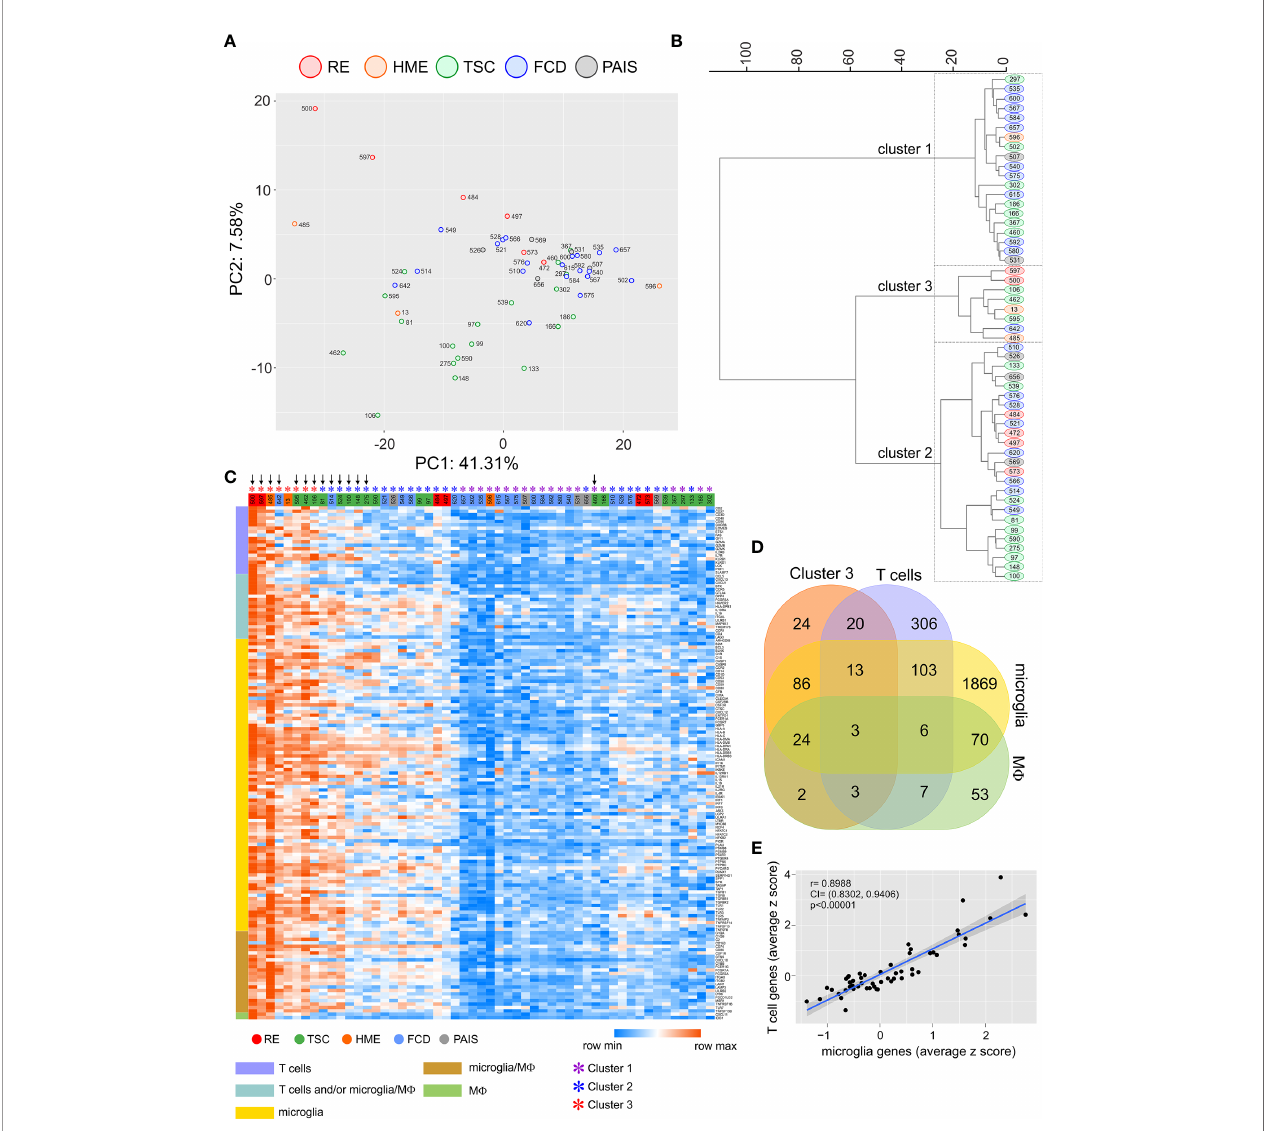
FIGURE 1 | Quanti fi cation of immune cells transcripts in resected brain tissue from epilepsy surgeries. A NanoString ® immune cell pro fi ling oligonucleotide array was used to quantify transcripts expressed by T cells, macrophages and microglia in brain specimens from 53 pediatric epilepsy surgery cases. (A) PCA plot calculated from the batch corrected normalized data. (B) Hierarchical clustering (Ward ’ s method) of the PCA coordinates resulted in three clusters. (C) Heat map after hierarchical clustering (Euclidean distances) showing the modi fi ed z scores (based on the median) of 86 percent of the genes whose expression was signi fi cantly higher (p < 0.0001) in Cluster 3 and could be assigned to T cells, microglia or macrophages (M Ф ). Vertical down arrows mark the cases from which TCR V b sequences were obtained. (D) Venn diagram showing the assignment of 151 out of 175 genes whose expression was signi fi cantly higher (p < 0.0001) in Cluster 3 to T cells, microglia or macrophages. (E) Plot showing a positive linear correlation between the expression of T cell speci fi c genes and microglia speci fi c genes in brain tissue from 53 epilepsy